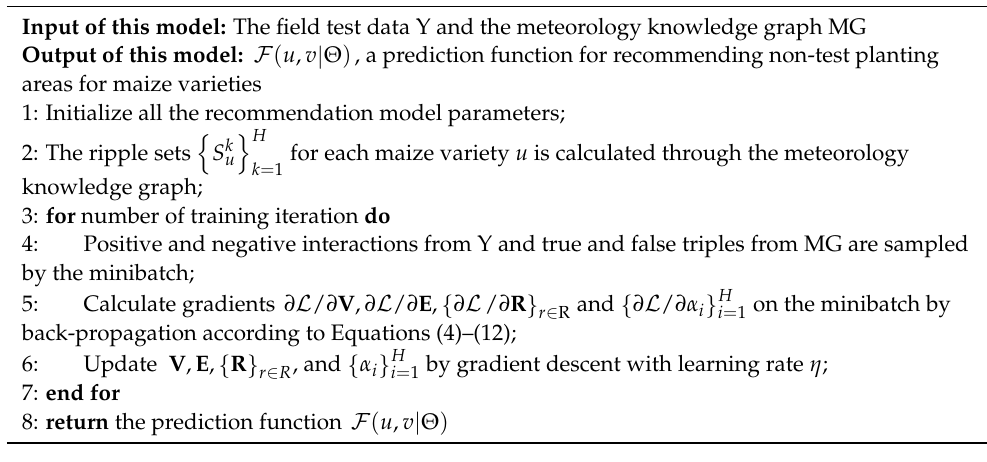
Algorithm 1: Learning algorithm for the recommendation model based on RippleNet